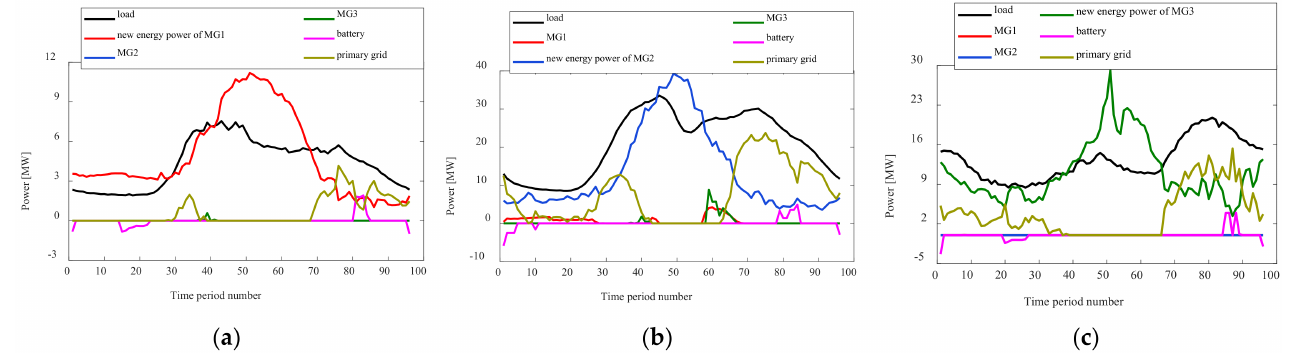
Figure 6. Microgrid of different areas: ( a ) MG1; ( b ) MG2; ( c ) MG3.